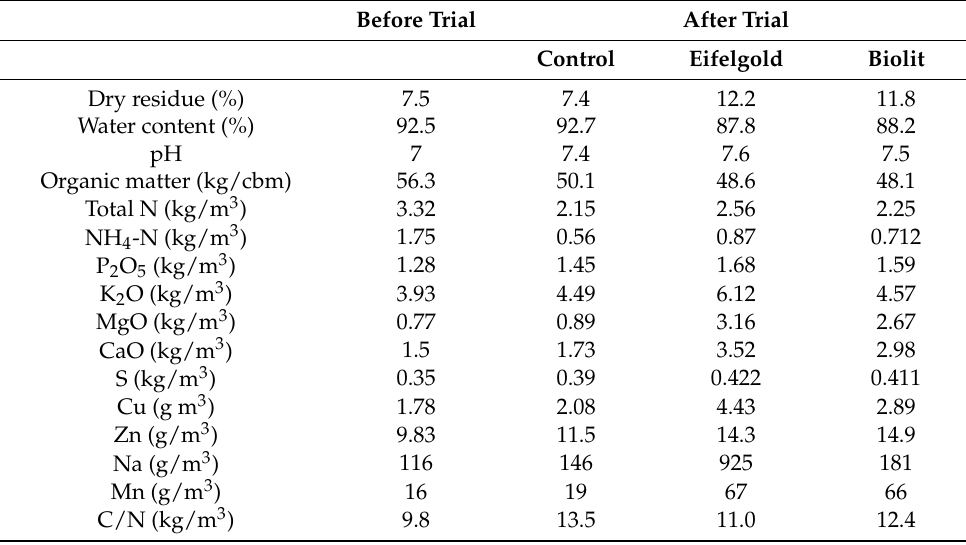
Table 4. Summary Physicochemical properties of the slurry before and after the trial. Before Trial After Trial Control Eifelgold